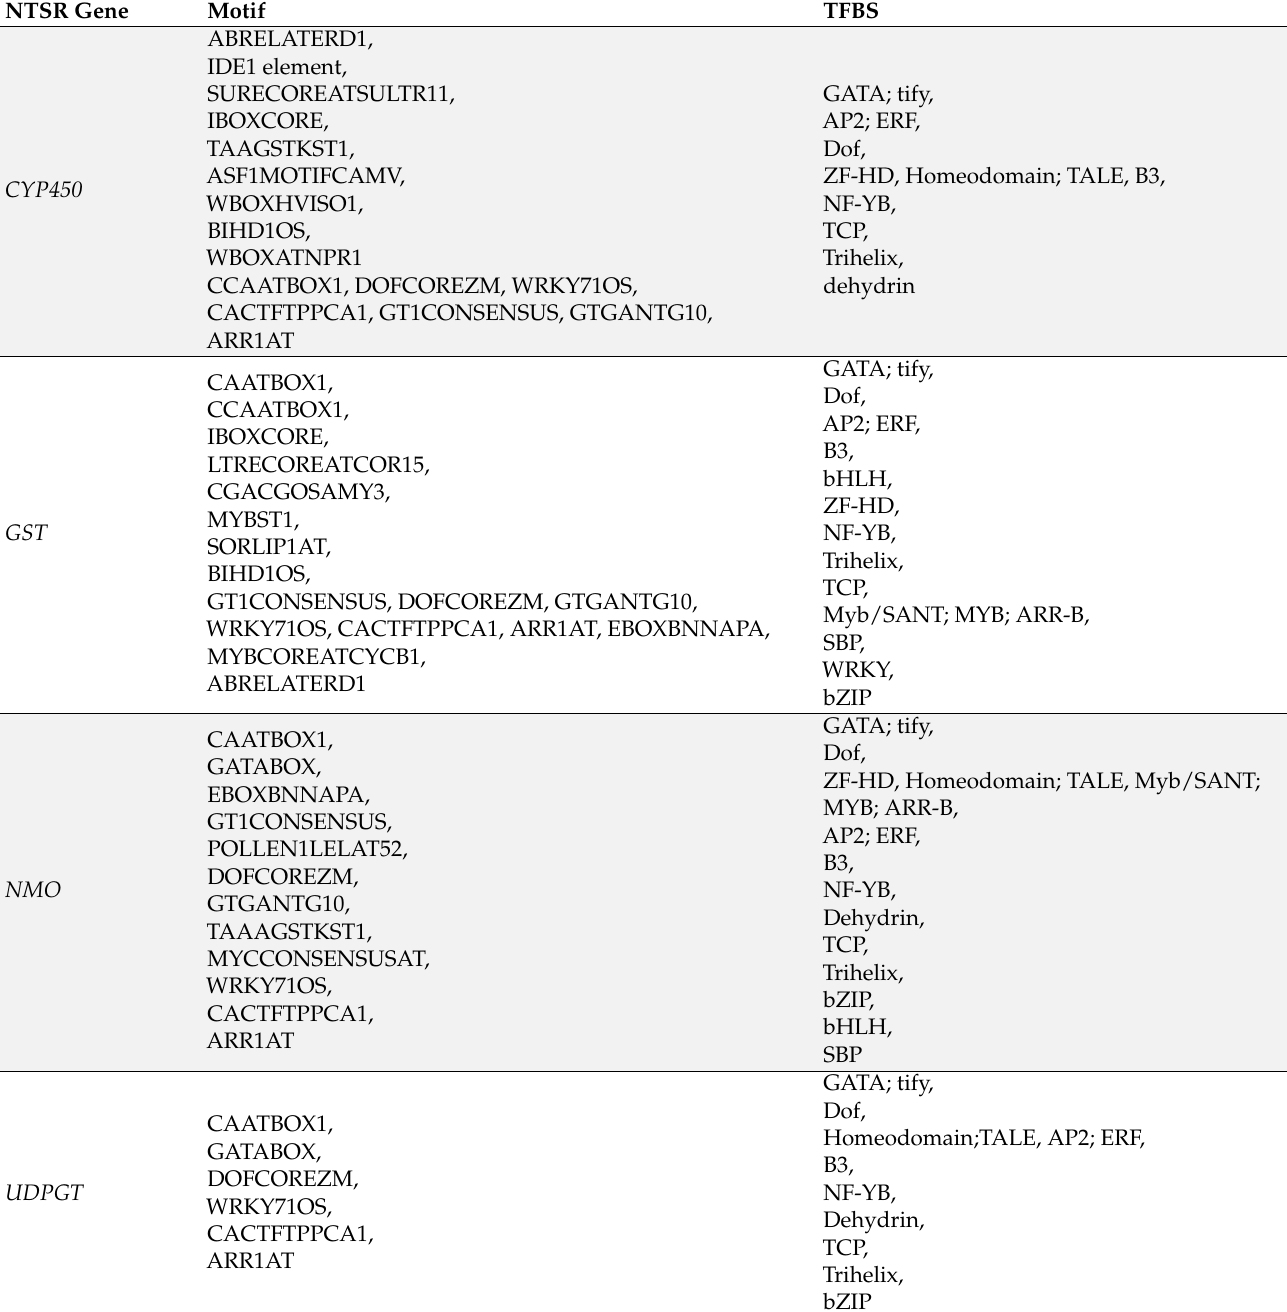
Table 3. List of dominant motifs and TFBS present in all four NTSR